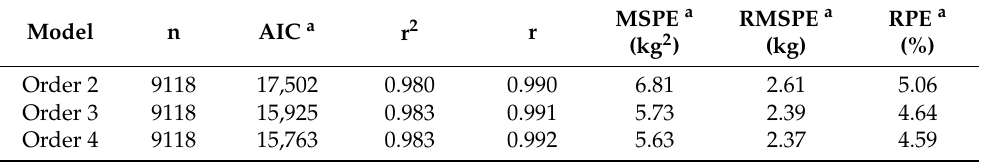
Table 1. Prediction accuracy of second, third, and fourth-order polynomial spline models for the prediction of ewe adjusted live weight over three